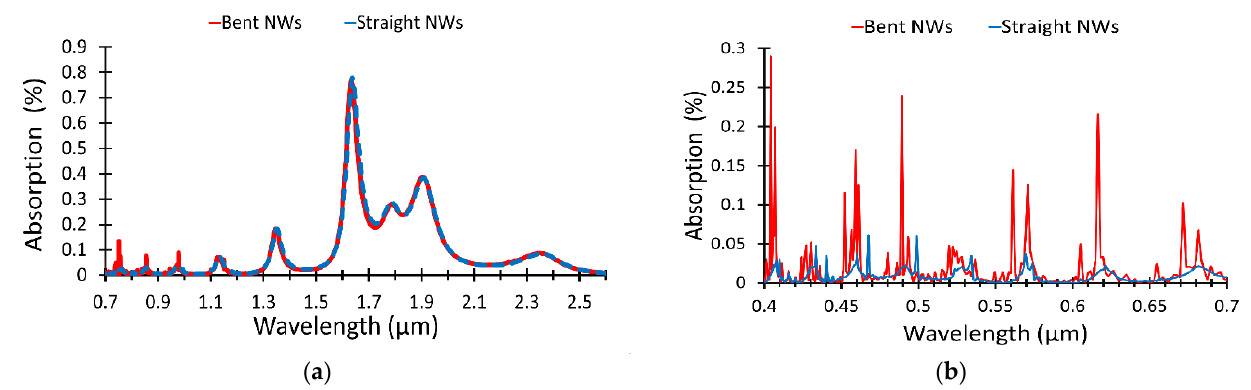
Figure 7. Light absorption vs. wavelength for straight and bent NWs ( a ) at NIR ( b ) visible bands.